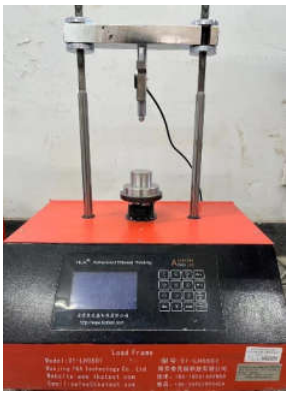
Figure 2. UCS test system.